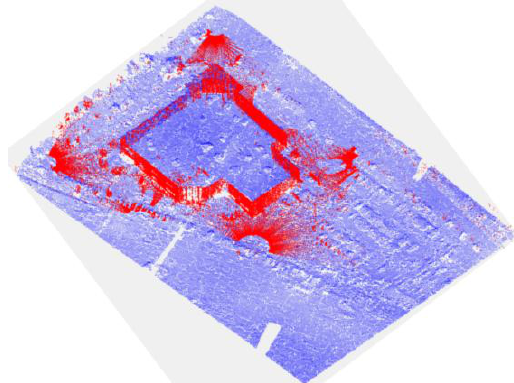
Figure 5. Alignment of UAV and TLS point clouds (Note: the original point clouds have been resampled for computational